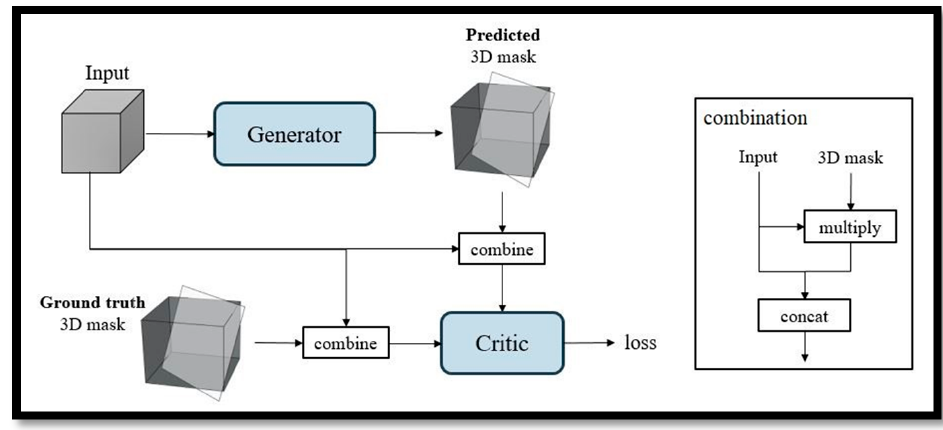
Figure 3. Training Figure 3. Training phase.